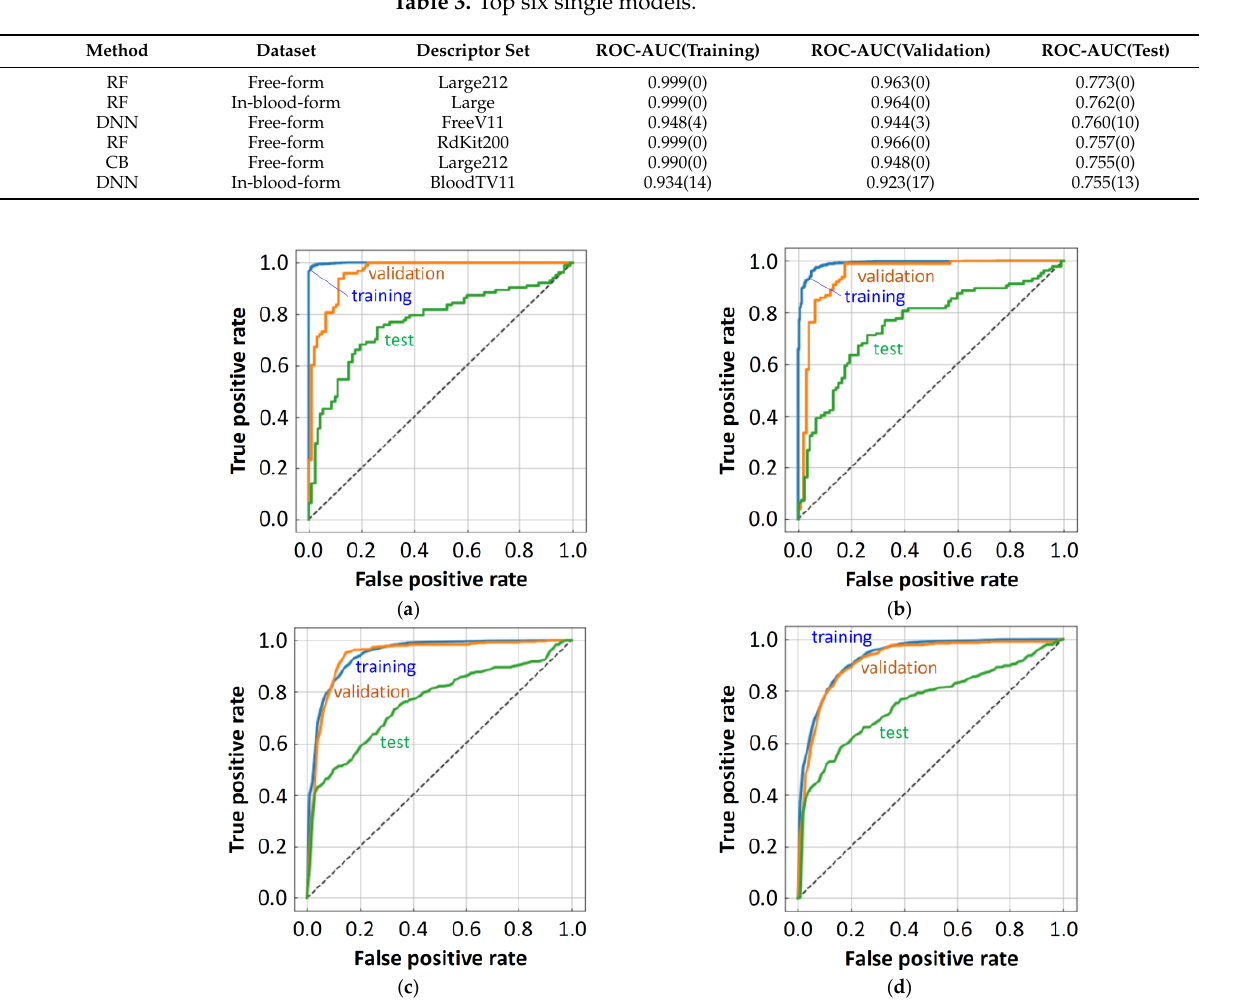
Figure 9. ROC curves for RF:Free(Large212) ( a ), CB:Free(Large212) ( b ), DNN:Free(FreeV11) ( c ), and DNN:Blood(BloodTV11) ( d ).